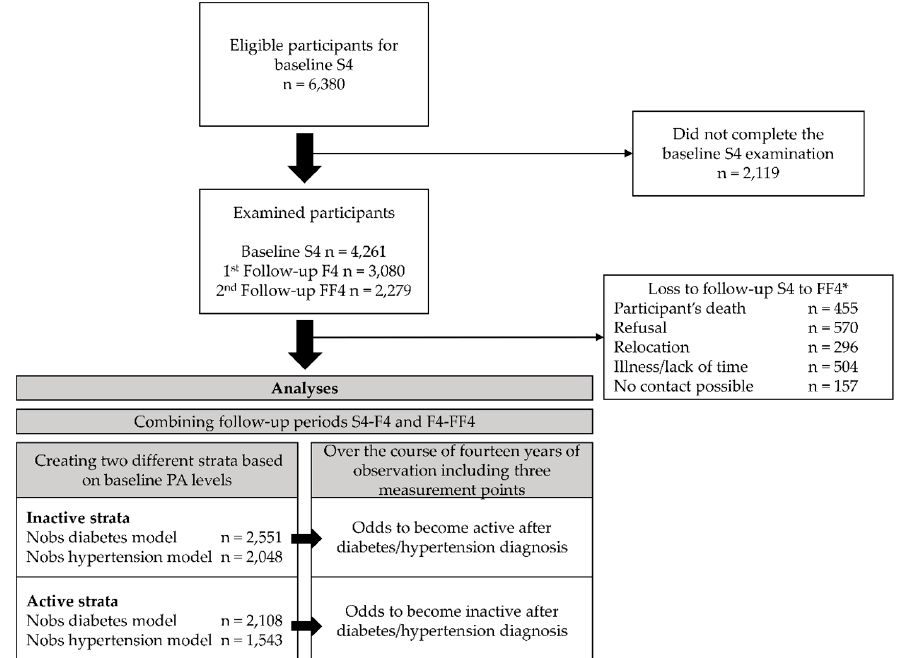
Figure 1. Study population and analysis flow chart. * Of the baseline S4 sample, 174 died, 204 moved outside the study region or to an unknown location, and 12 refused to be further contacted. Of the remaining 3871 eligible participants, 176 could not be contacted, 220 were too ill or busy, and 395 refused to participate further. Thus, 3080 participants (80% response rate) took part in the first follow-up F4 (2006-2008) examination. Of the F4 sample, 168 died, 97 moved outside the study region or to an unknown location, and 67 refused to be contacted further. Of the resulting eligible 2748 participants, 48 could not be contacted, 332 were too ill or busy, and 207 refused to participate further. Adding 118 participants from S4 without F4 information, 2279 (79% response rate, excluding 118 participants without F4 information) participants took part in the second follow-up FF4 (2013–2014) examination. Annotations: n = number of participants, Nobs = number of